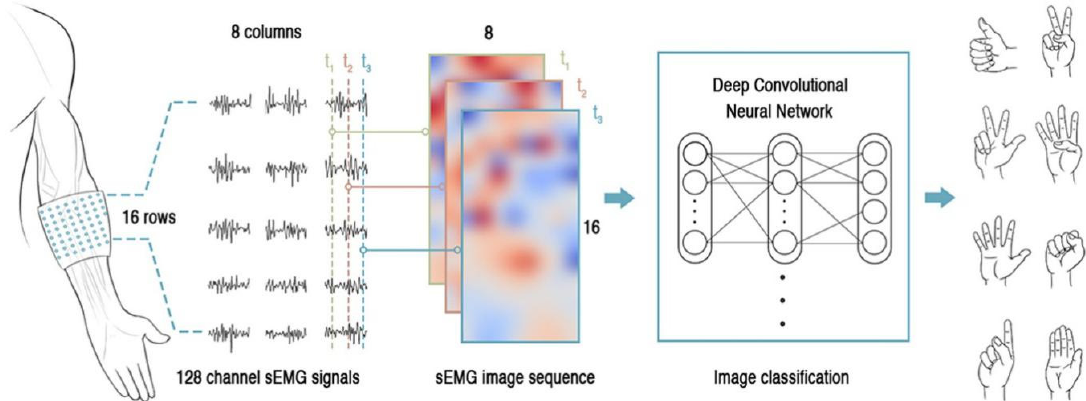
Figure 12. The procedure of applying High-Density EMG (HD-EMG) in discriminating hand gestures, adopted from [126] .